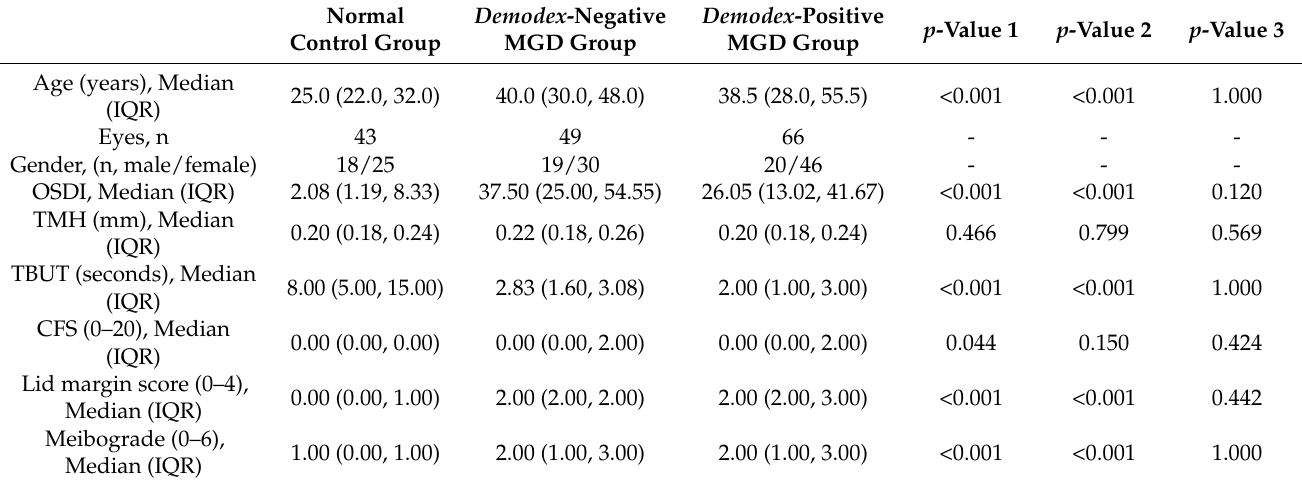
Table 1. Patient basic characteristics and the clinical parameters of three